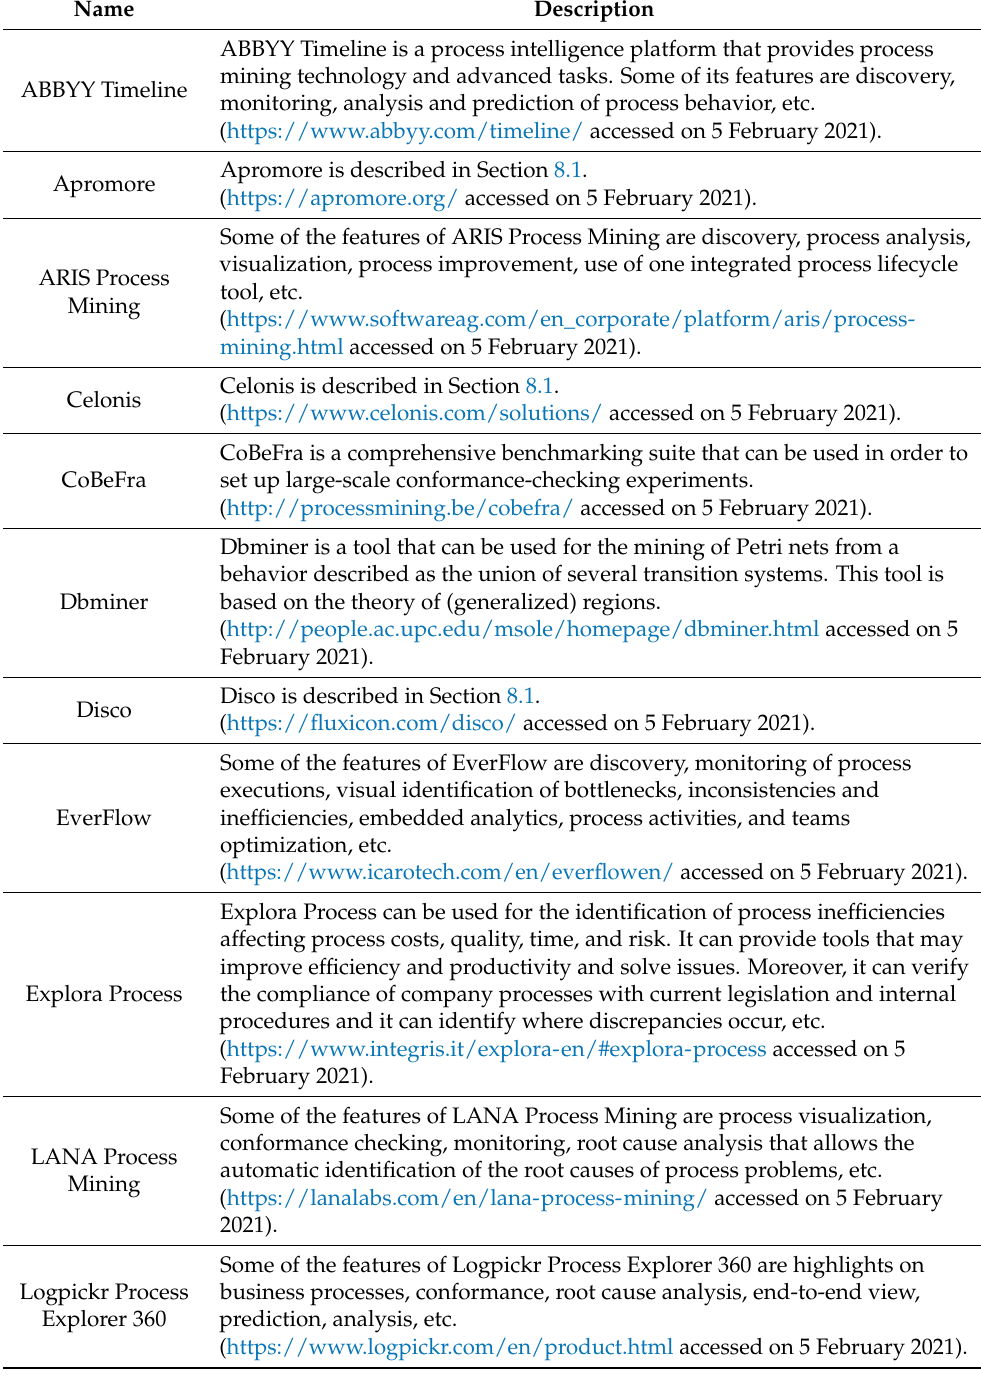
Table 1. Software tools that can be used for the execution of operations related to process